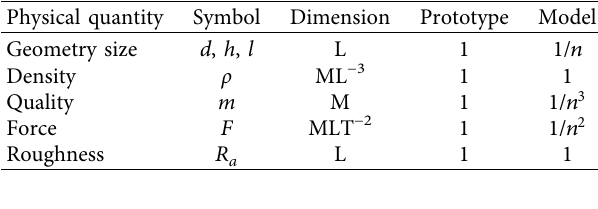
Table 14: Similarity rate of related